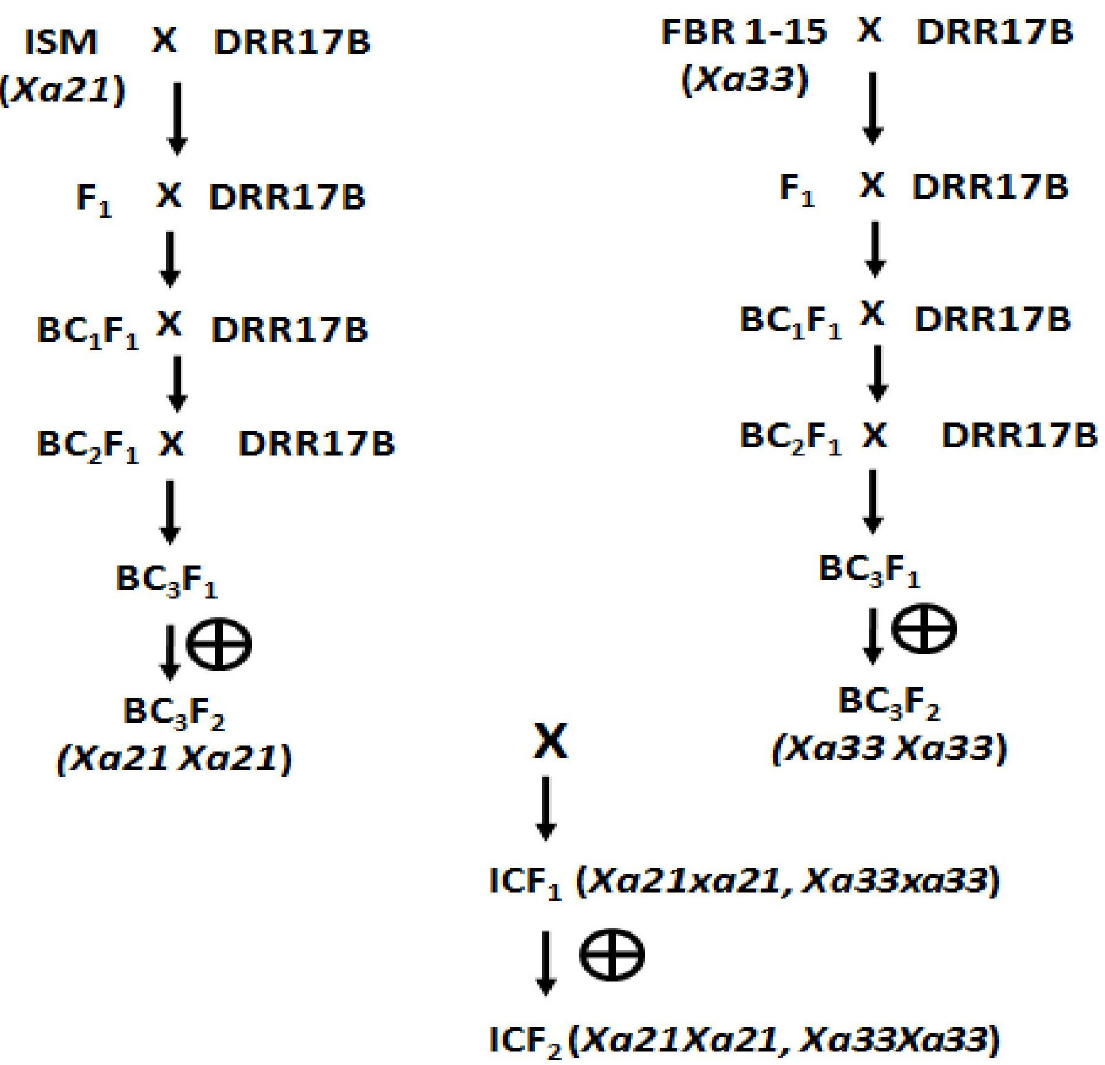
Fig 1. Marker-assisted backcrossing scheme adopted in the